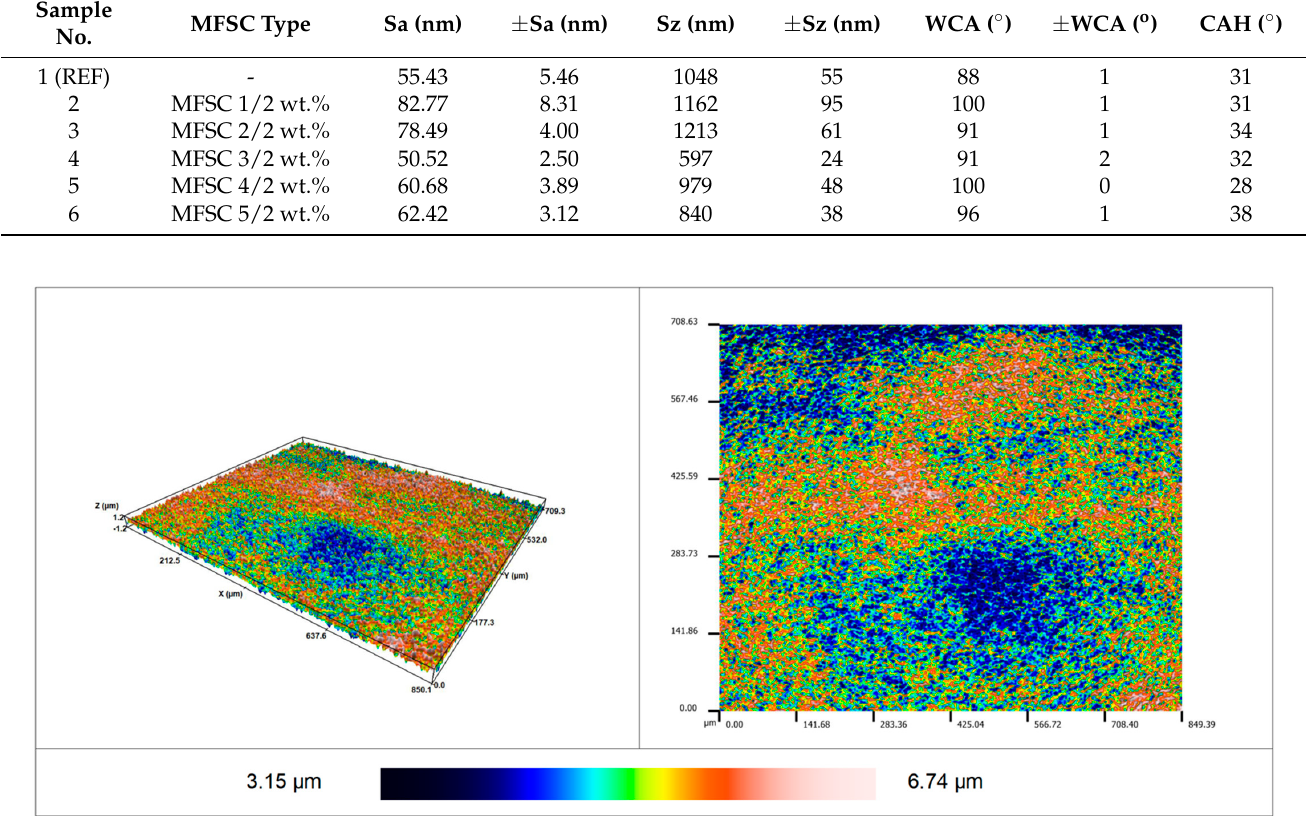
Table 2. The surface parameters of gelcoat samples.